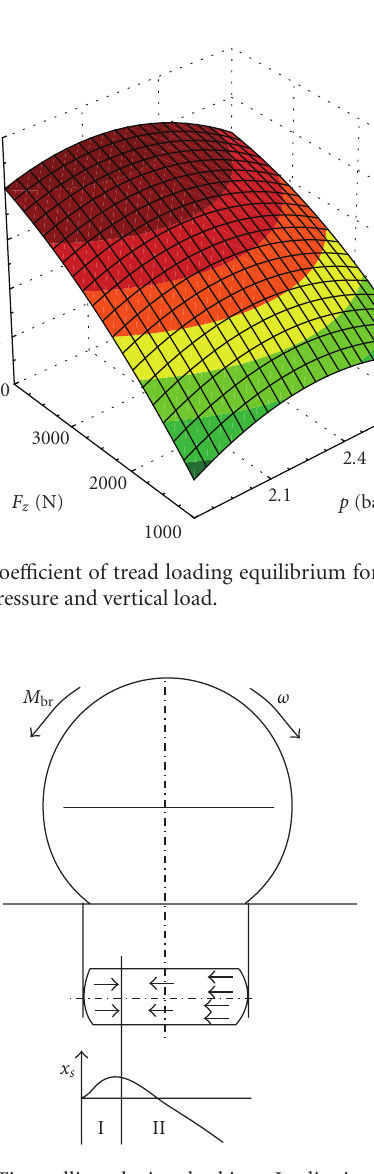
Figure 11: Tire rolling during braking. I: slipping region; II: adhesion region; x s : friction contact length.